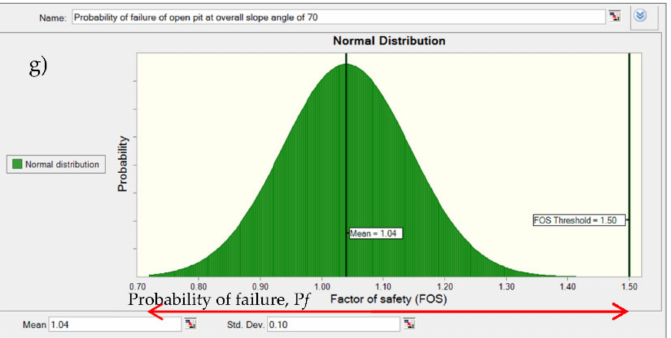
Figure 5. Probability density function (PDF) curves for factor of safety ( FOS ) at various overall slope angles after 27 simulations. ( a ) P f at overall slope angle of 20 ◦ , ( b ) P f at overall slope angle of 30 ◦ , ( c ) P f at overall slope angle of 40 ◦ , ( d ) P f at overall slope angle of 45 ◦ , ( e ) P f at overall slope angle of 50 ◦ , ( f ) P f at overall slope angle of 65 ◦ and ( g ) P f at overall slope angle of 70 ◦ .